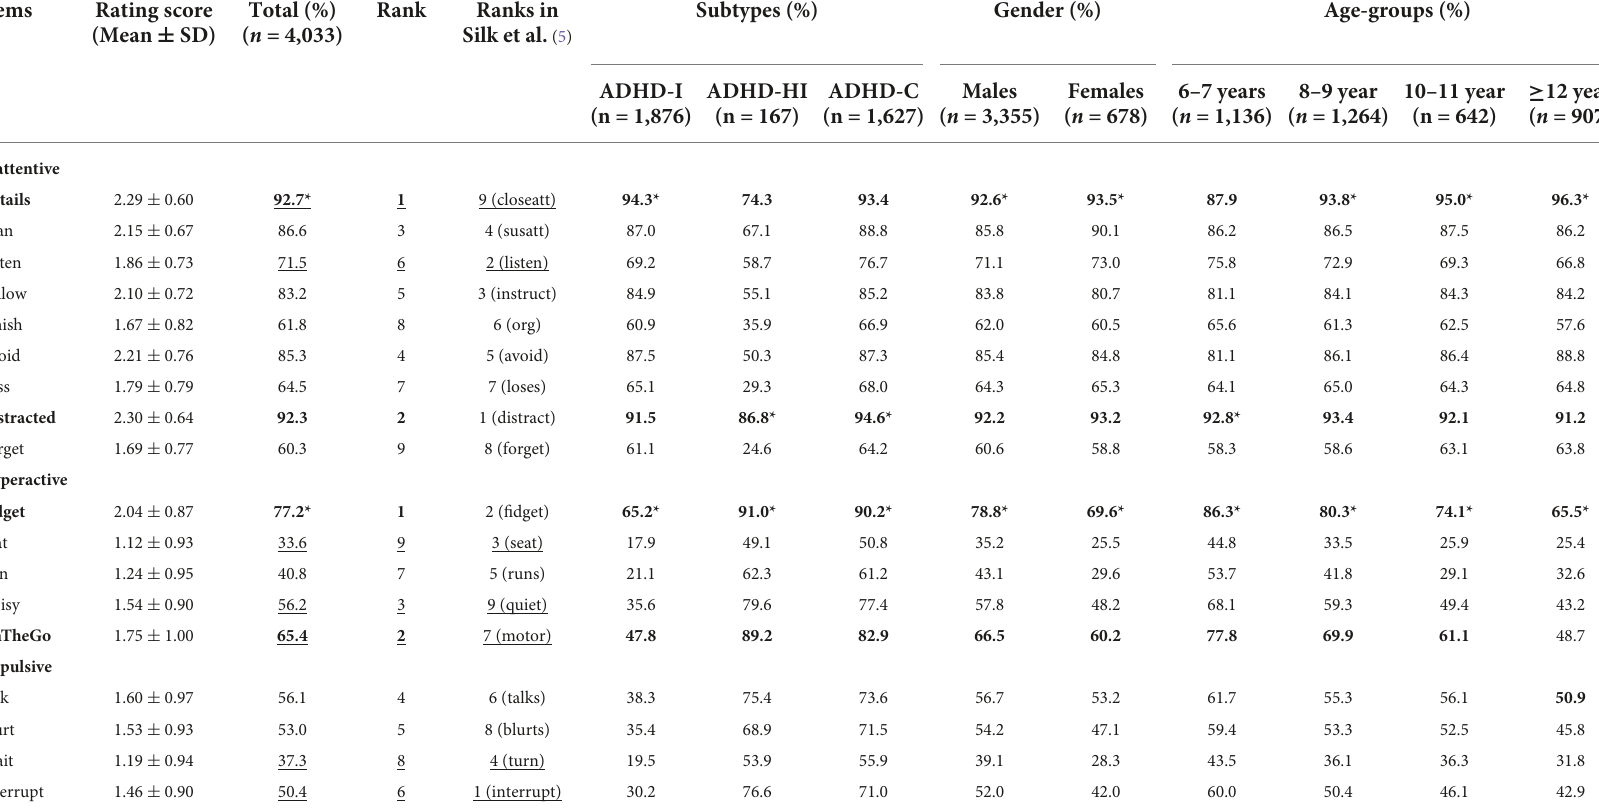
TABLE 2 The mean rating scores and the frequencies of endorsement for each symptom in the entire sample and subgroups of ADHD.